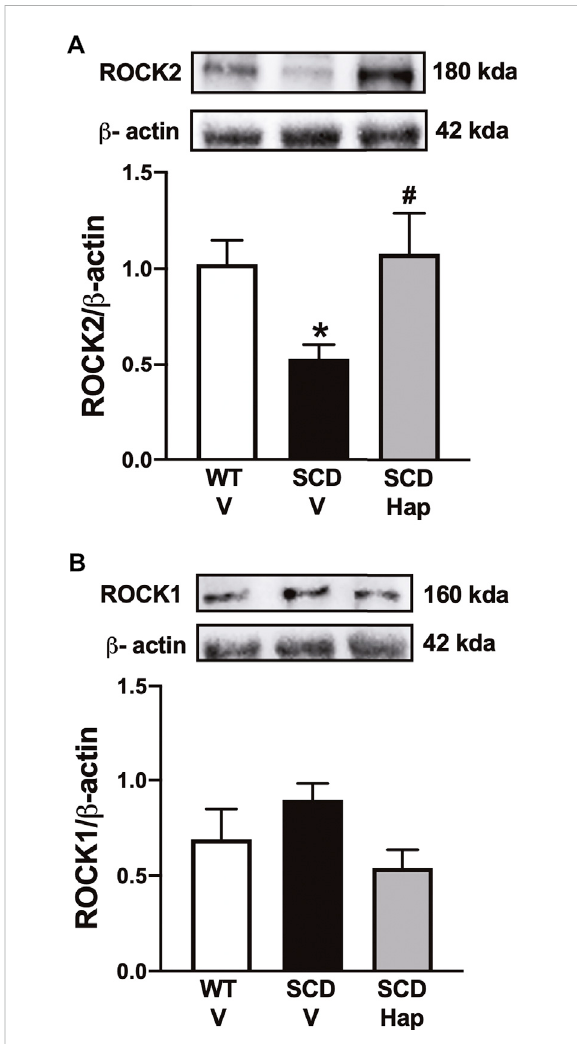
FIGURE 5 Representative images of western blotting (top panels) and protein values (bottom panels) for ROCK2 (A) and ROCK1 (B) in homogenates of penises from WT and SCD mice treated or not with haptoglobin (Hap). Data represent the mean ± S.E.M. for 6 mice in each group. A single band for ROCK1 and ROCK2 was normalized to β -actin. * p < 0.05 vs. WT-Vehicle; # p < 0.05 vs.